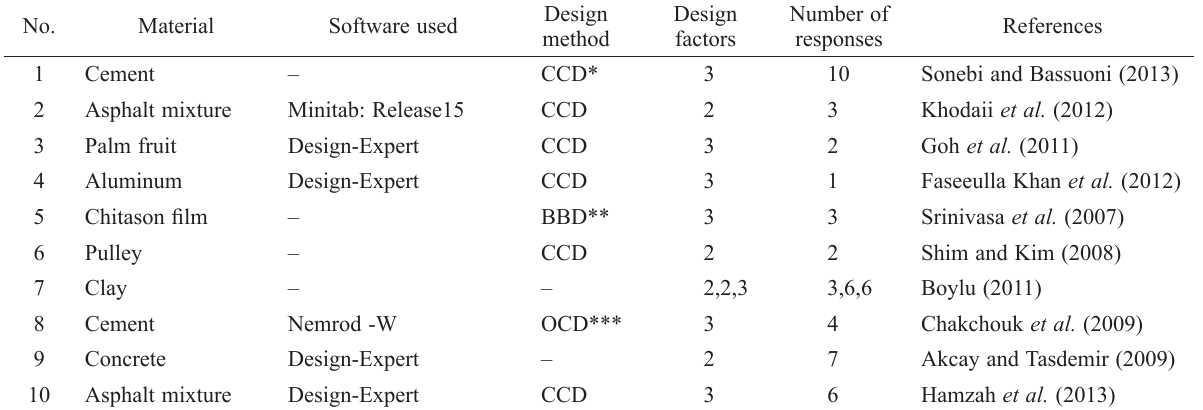
Table 1. Use of RSM in some applied sciences No.